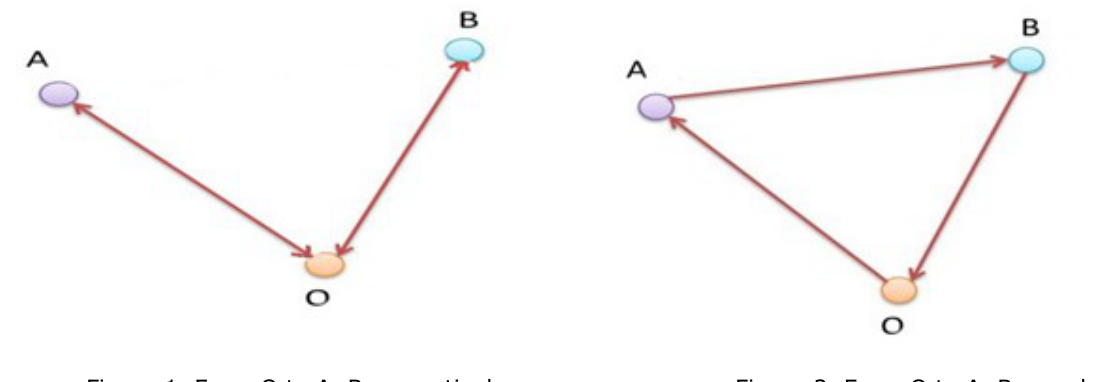
Figure 1. From O to A, B respectively Figure 2. From O to A, B